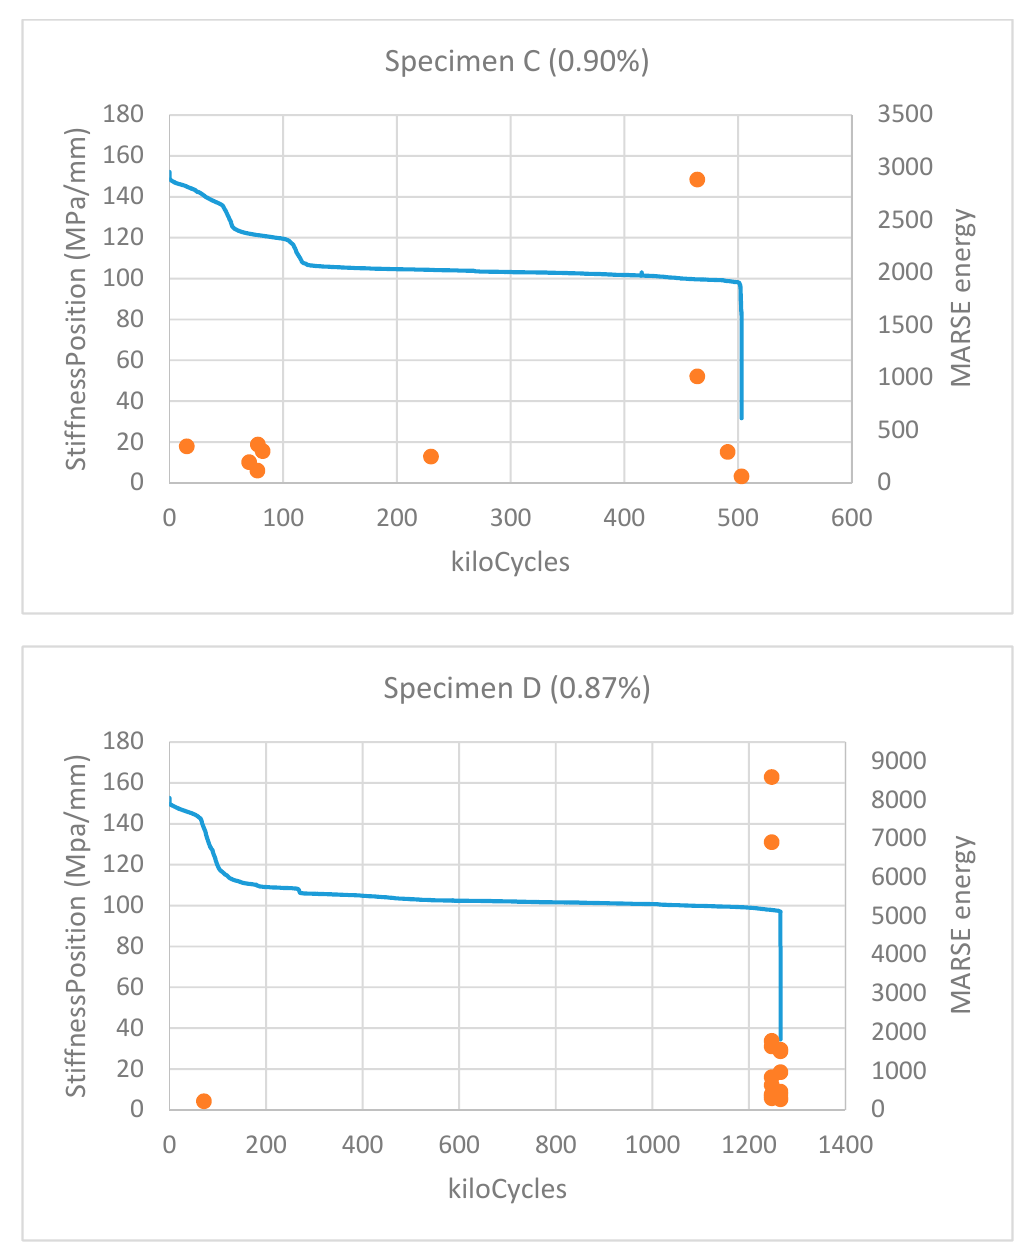
Figure 12. Stiffness response for the tested specimens B, C, and D (MPa/mm) illustrating the standard phase I, II, and III of the tensile fatigue test. Additionally, shown on the same time axis is the occurrence of high amplitude AE hits during phase I and II, and in the case of the prematurely failed specimen C, also in phase